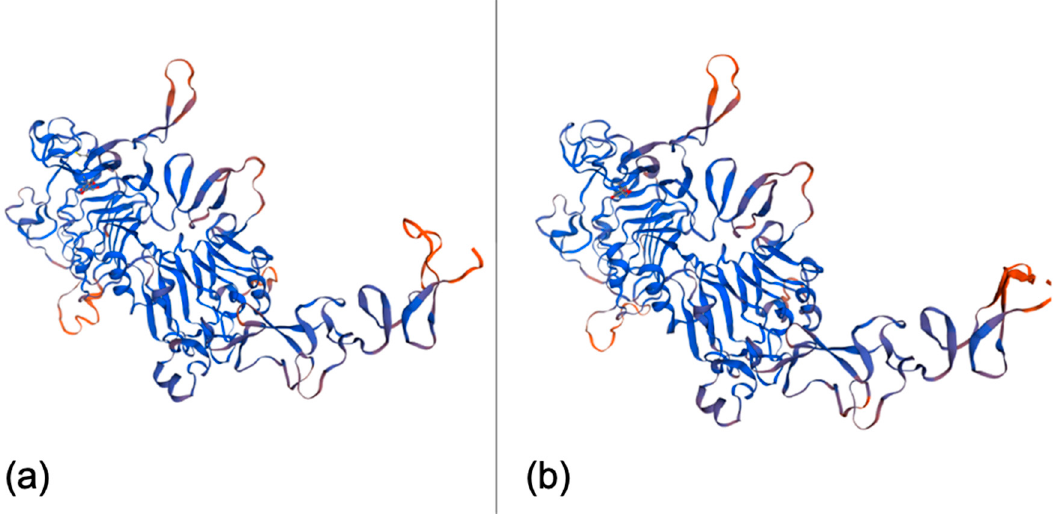
Figure 2. ( a ) 3D model of human HER2 generated from the UniProtKB/Swiss-Prot sequence P04626.1. ( b ) Canine HER2 3D model generated from the NCBI reference sequence NP_001003217.2. Both images were generated using the online tool Swiss model (Swiss Institute of Bioinformatics, Basel, Switzerland) (https://swissmodel.expasy.org/ (accessed on 14 May 2021)).